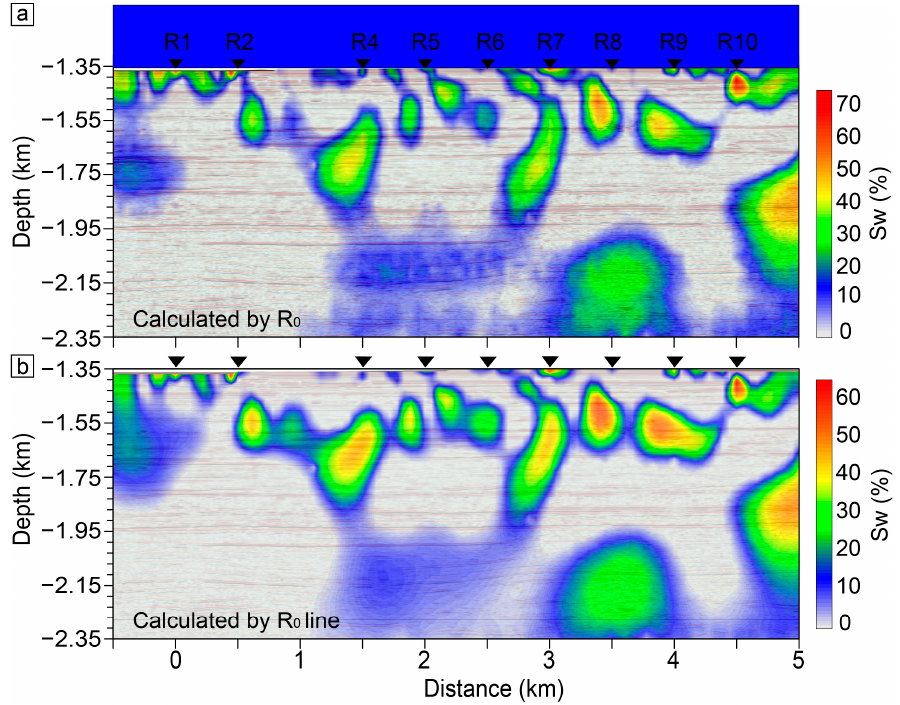
Figure 9. Gas hydrate saturation of the study region calculated using Archie’s law: ( a ) Gas hydrate saturation calculated from R 0 ; ( b ) Gas hydrate saturation calculated using the R 0 line.